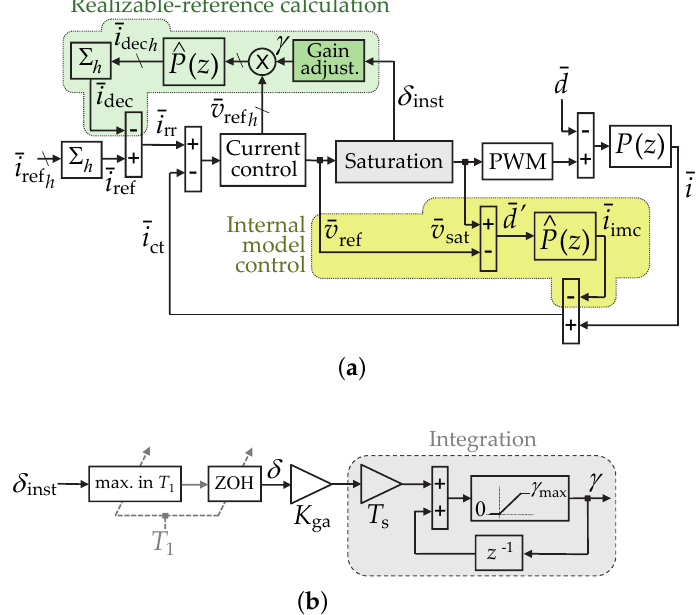
Figure 32. Simplified representation of the multifrequency distortion-free method used for three- phases in [137,557,572] and for n phases in [545]. Coordinate transformations are omitted. In this figure, a dash over a line indicates multiple harmonics h , not values for several phases; the latter is just denoted by overbar in the corresponding variable. P ( z ) and (cid:98) P ( z ) denote the actual plant and its nominal model, respectively. T 1 and T s are fundamental and sampling period, respectively. δ inst and δ are the instantaneous and per- T 1 , respectively, ¯ v ref excess with respect to the output-voltage boundary. ¯ i rr represents the realizable references. d is voltage disturbance. ZOH stands for zero-order hold. ( a ) General view. ( b ) Content of gain-adjustment